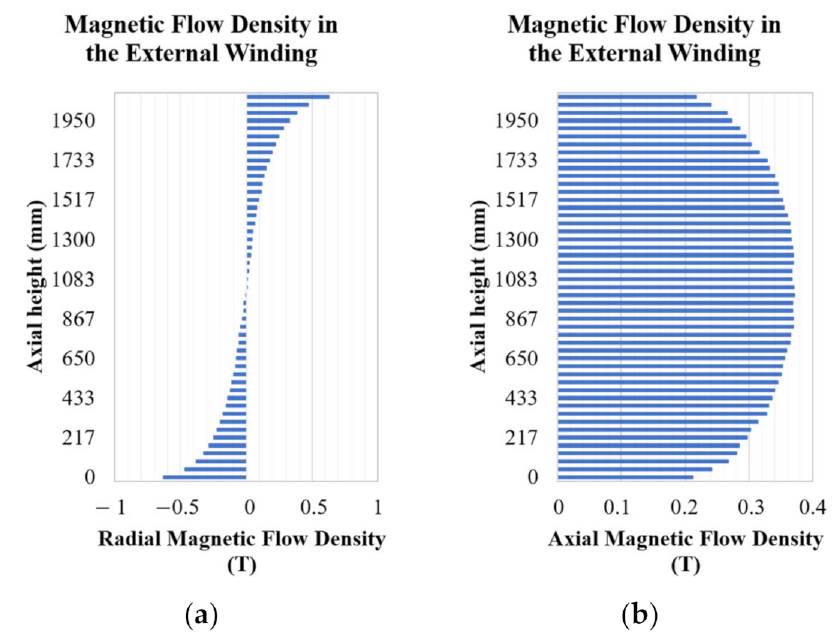
Figure 12. Magnetic flux density: ( a ) radial, ( b )